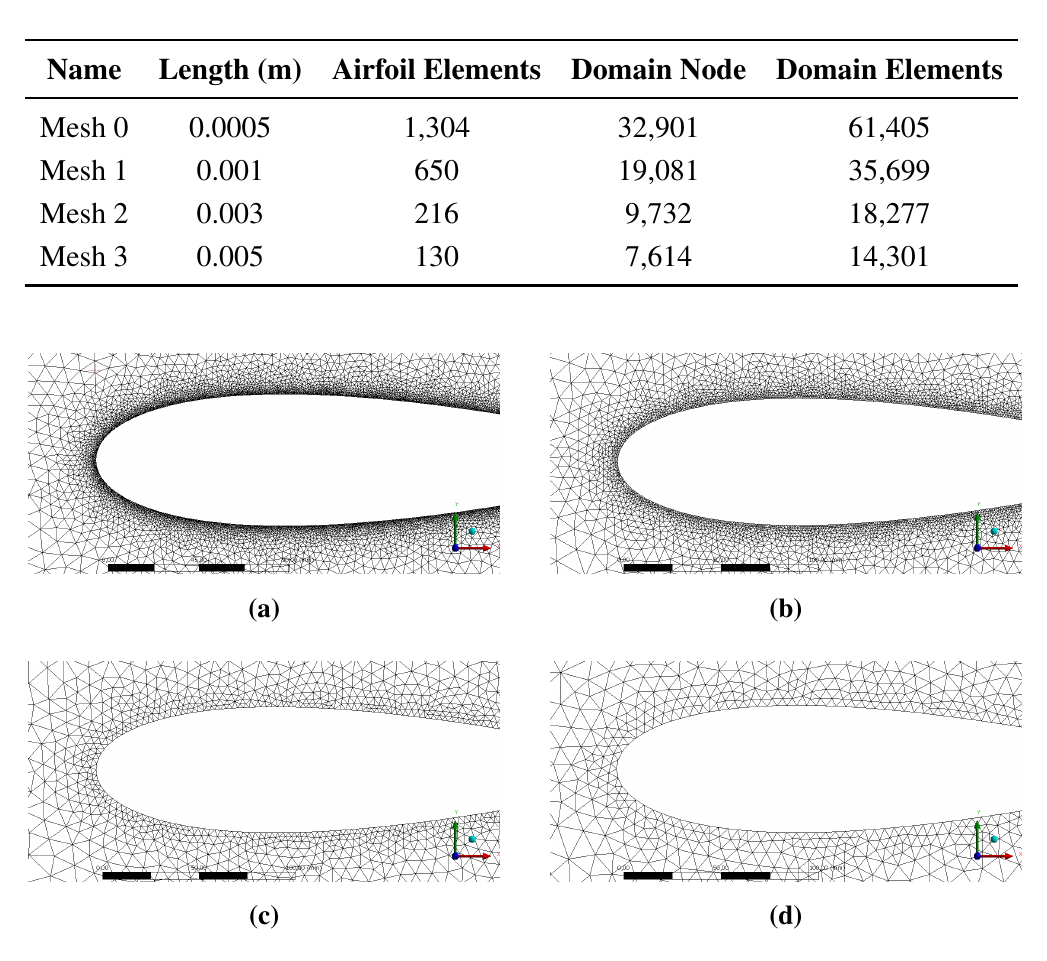
Table 1. Mesh discretization values.